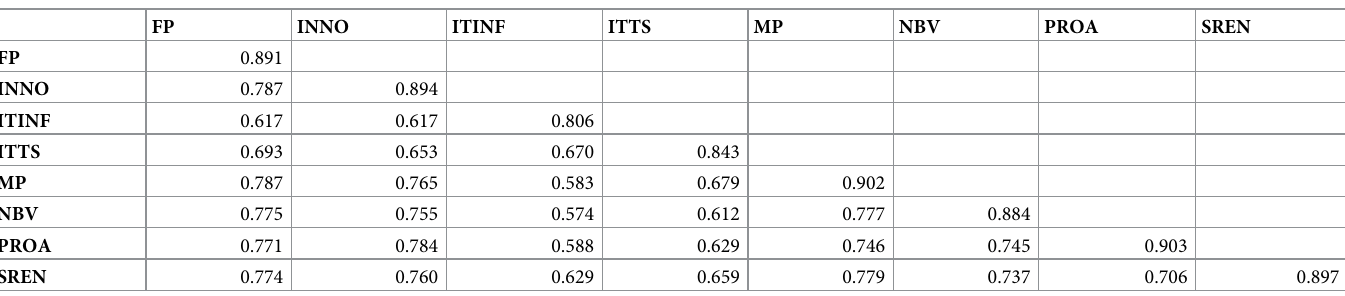
Table 4. Correlation between constructs.